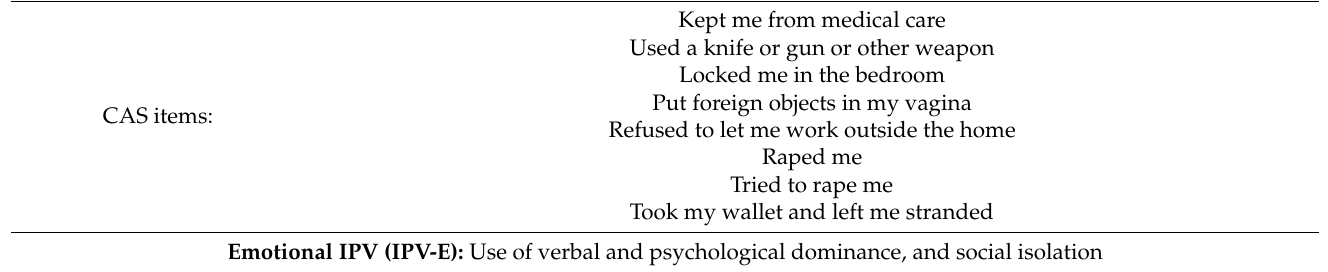
Table 1. Definition of IPV